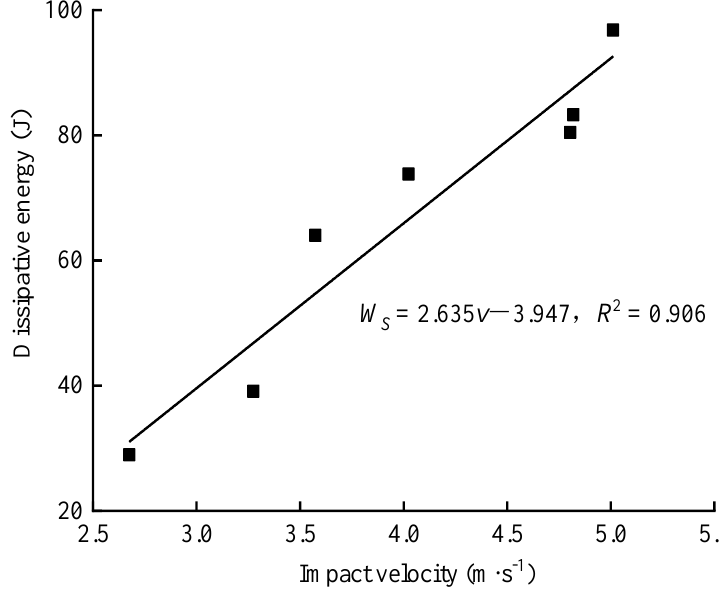
Figure 11. Variation of dissipated energy with bullet impact velocity.